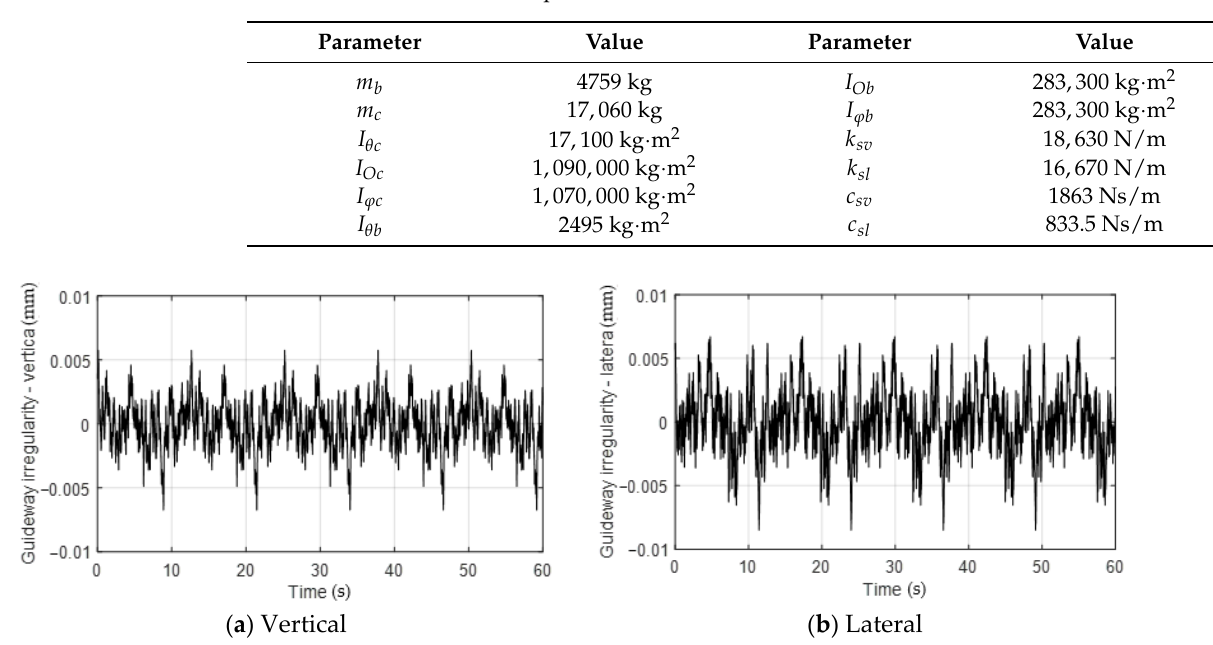
Figure 15. Dynamic model of the capsule train with the main parameters. Table 10. Parameters of the capsule vehicle for simulation.